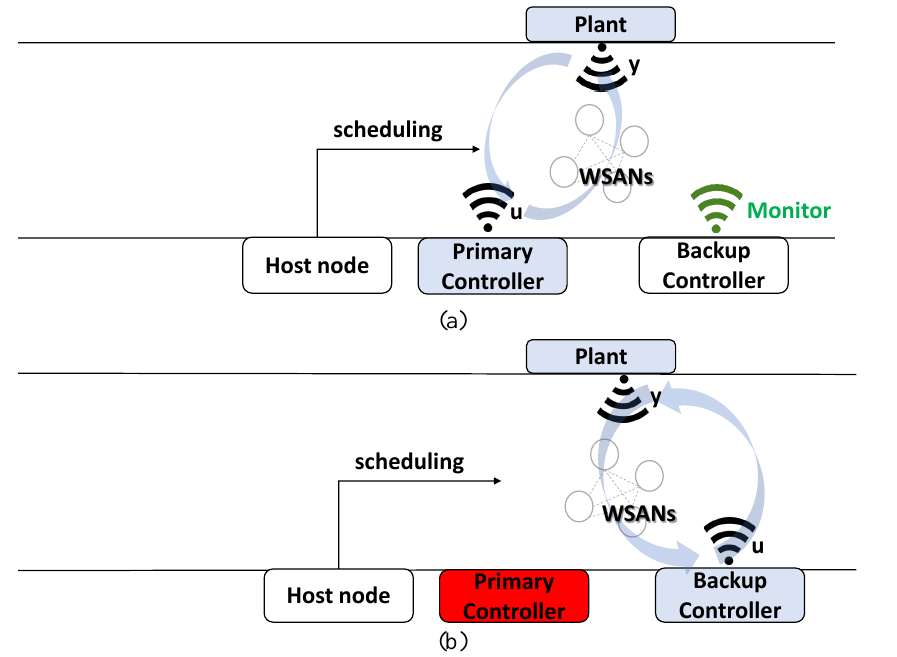
Figure 3. Process of proposed controller switching mechanism ( a ) before and ( b ) after controller switching.